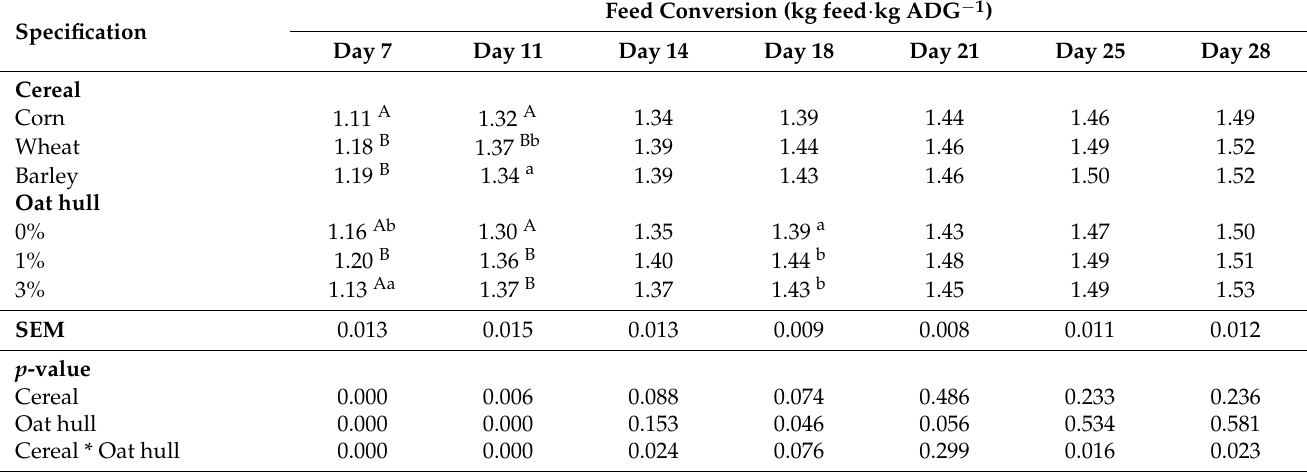
Table 5). Table 5. Feed conversion of broiler